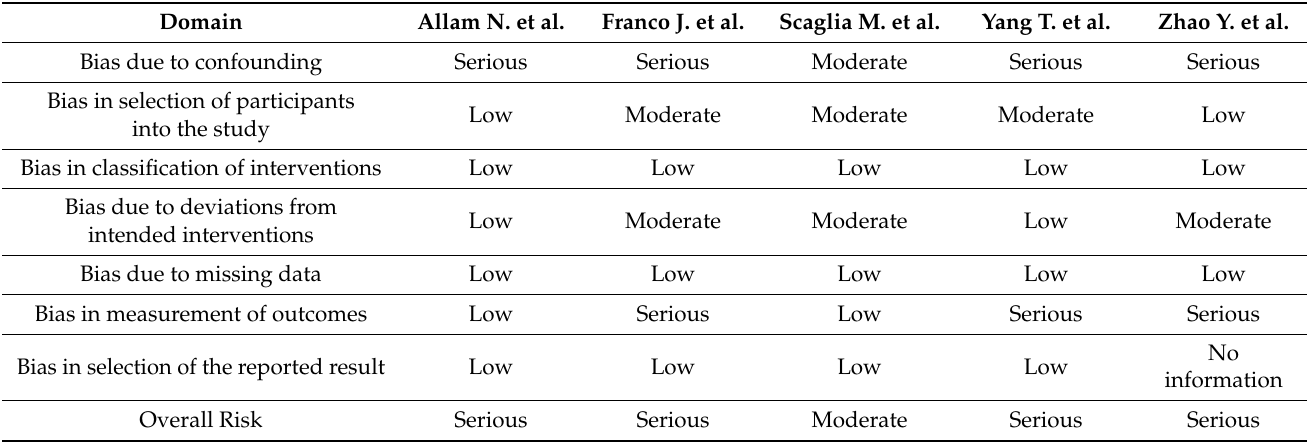
Table 2. Risk of bias assessment of studies included in the